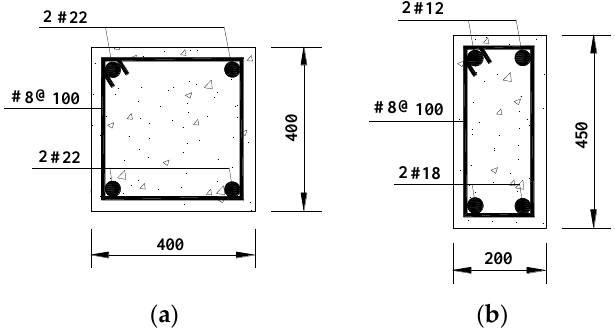
Figure 4. ( a ) Cross section of column; ( b ) beam. Table 1. Characteristic parameters of the structural